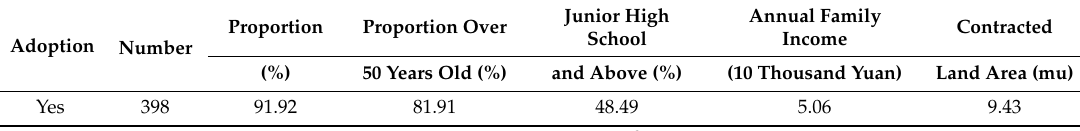
Table 4. Adoption rate of conservation agriculture (CA) technology.